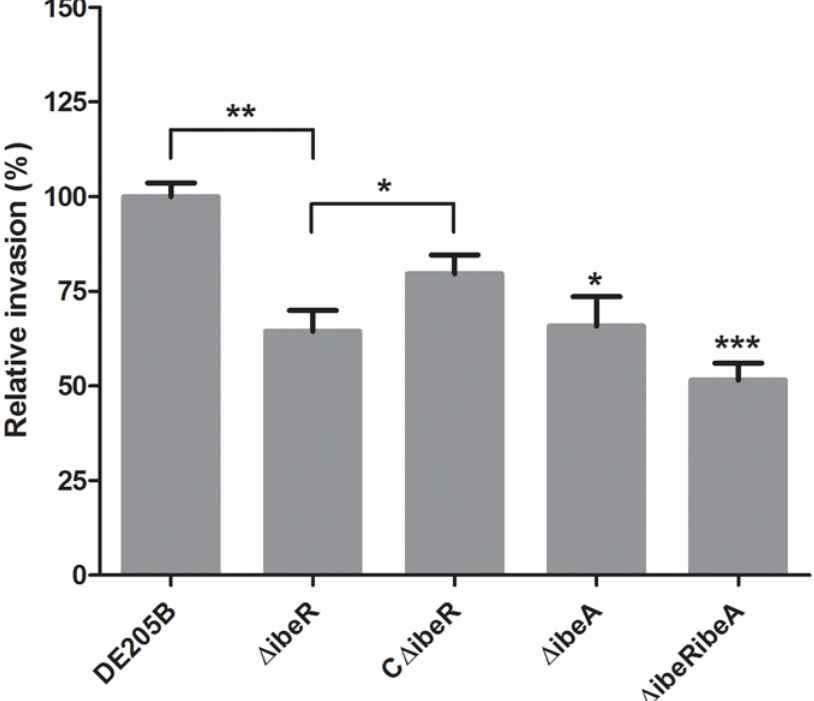
Fig 4. IbeR was involved in invasion DF-1 cells by DE205B. Invasion assays were performed on DF-1 cells. Values are average of three independent experiments. The error bars indicate standard deviations. One-way ANOVA was performed for statistical significance analysis. *** p < 0.001; ** p < 0.01; * p <